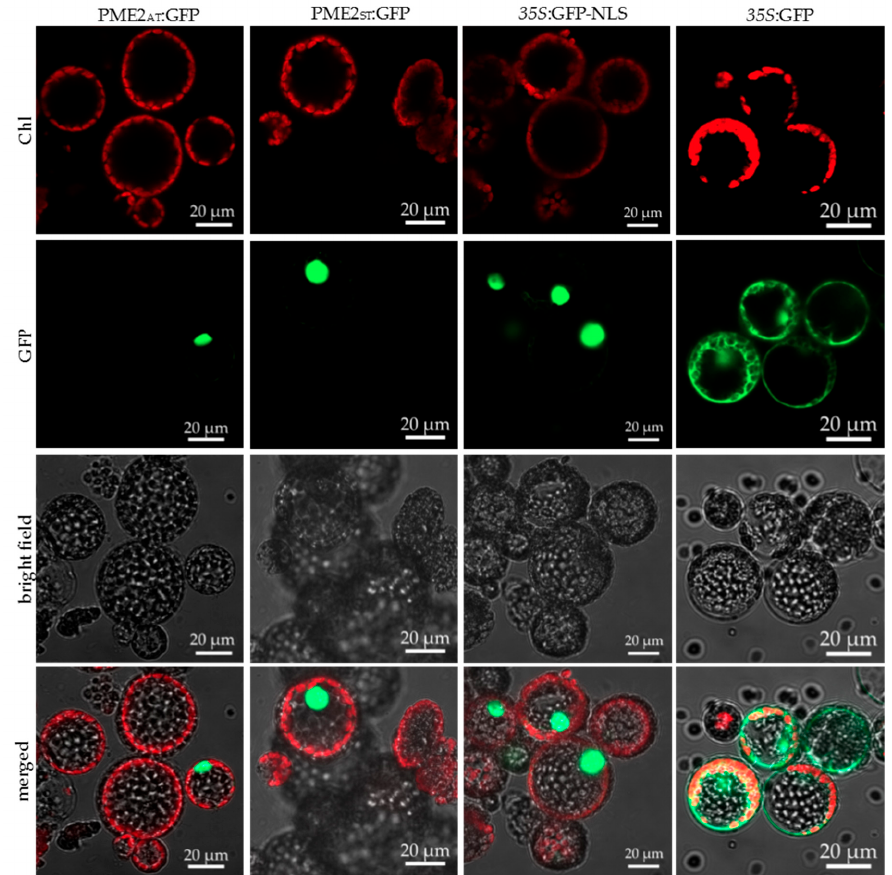
Figure 4. PME2 ST and PME2 AT are translocated to the nucleus of mesophyll protoplasts. Mesophyll protoplasts of Nicotiana benthamiana were transformed with the plasmid pGGZ001 encoding C-terminal GFP-tagged PME2 ST (first column), PME2 AT (second column), GFP N -terminally fused to a NLS sequence (third column), or GFP only as a control for nuclear localization (fourth column). Expression of the transgenes was under the control of a 35S promoter. The upper panel shows autofluorescence of chloroplasts (Chl), the second panel the signal derived from the GFP, and the third panel the bright field image and the last panel an overlay of all images (merged). Microscopic analysis was performed with a Zeiss LSM 800. Corresponding images after expression of mCherry-tagged PME2 and of use of Nicotiana occidentalis mesophyll protoplasts are presented in Figures S1–S3. Bars represent 20 µm.